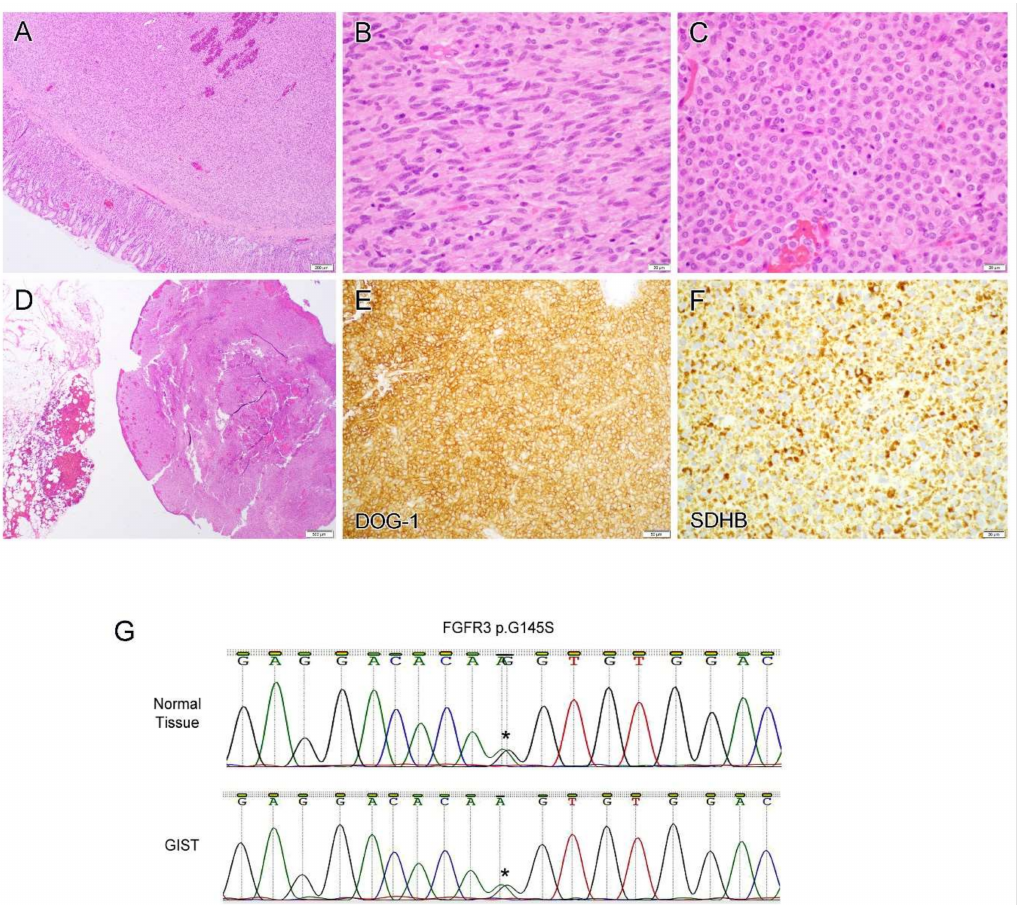
Figure 5. Case 18 was a 23-year-old woman with gastric-type gastrointestinal stromal tumor ( A ) which displayed spindle ( B ) and epithelioid morphology ( C ) and omental involvement ( D ). The tumor cells diffusely expressed DOG-1 ( E ) and displayed retained SDHB staining ( F ). Next-generation sequencing and Sanger sequencing revealed a FGFR3 p.G145S mutation/variant which was detected in both normal tissue and tumor ( G ). Star (*) indicates the mutation/variant site. Original magnification: ( A ), × 40; ( B , C ), × 400; ( D ), × 20; ( E , F ), ×